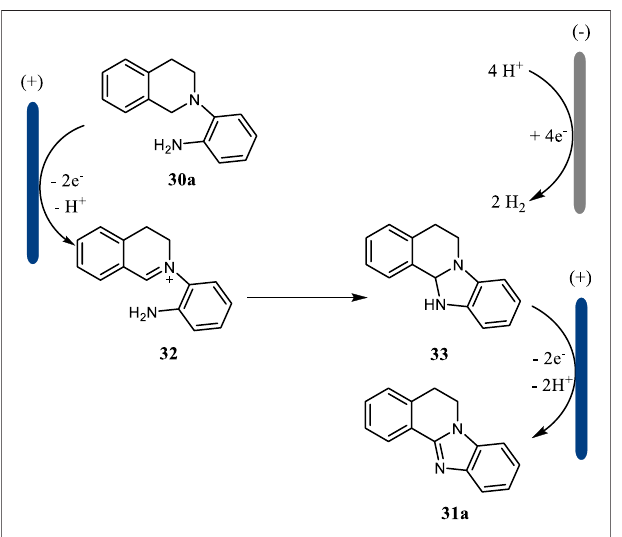
SCHEME 12 | The reaction mechanism for the formation of benzimidazoles.